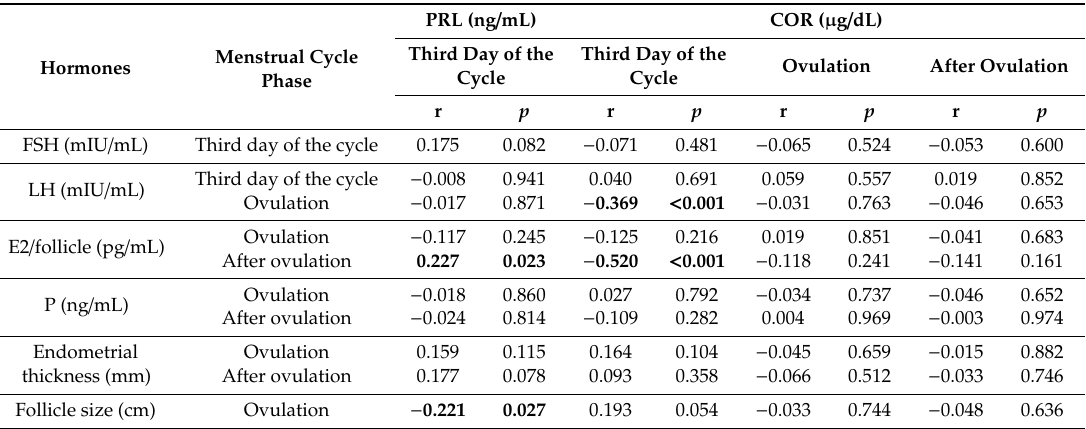
Table 3. Correlations between prolactin (PRL) and cortisol (COR) levels and the menstrual cycle course in women from the control group (N = 100). Significant correlations are in bold. Pearson’s correlation coe ffi cient was